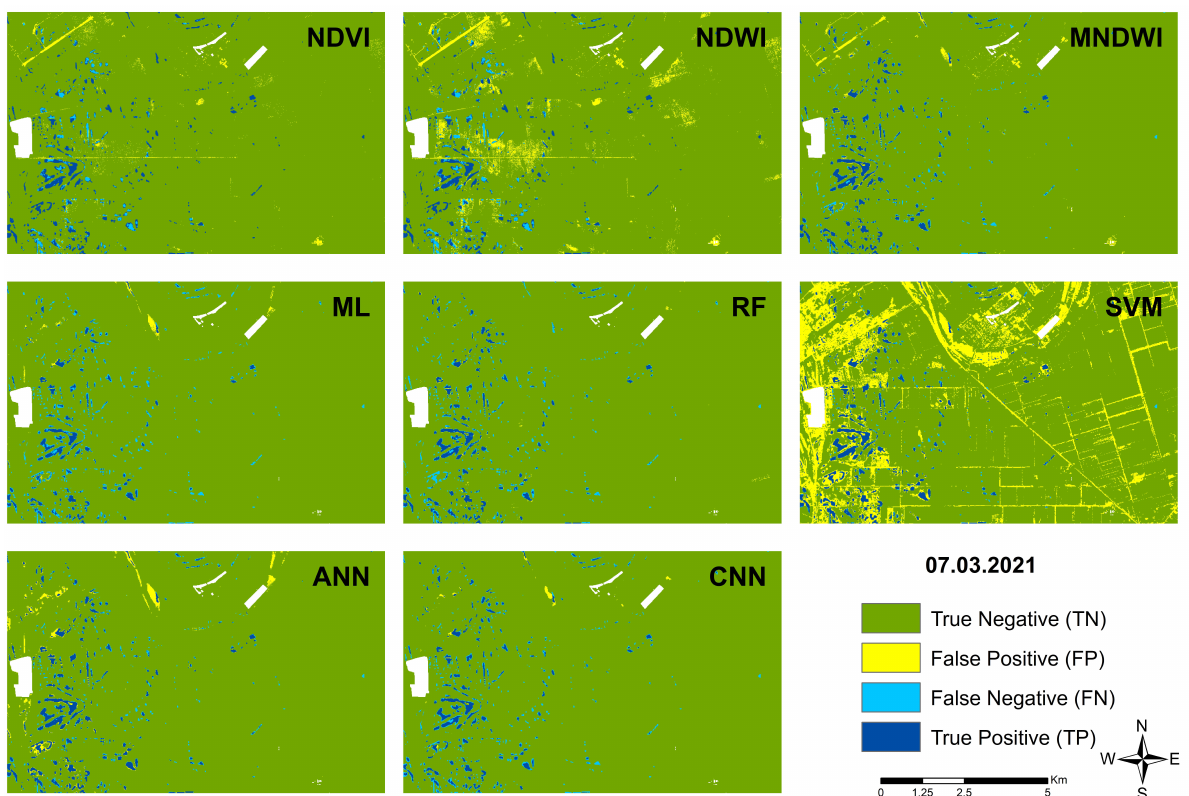
Figure 6. Results of the different classifications on 23 February 2021.